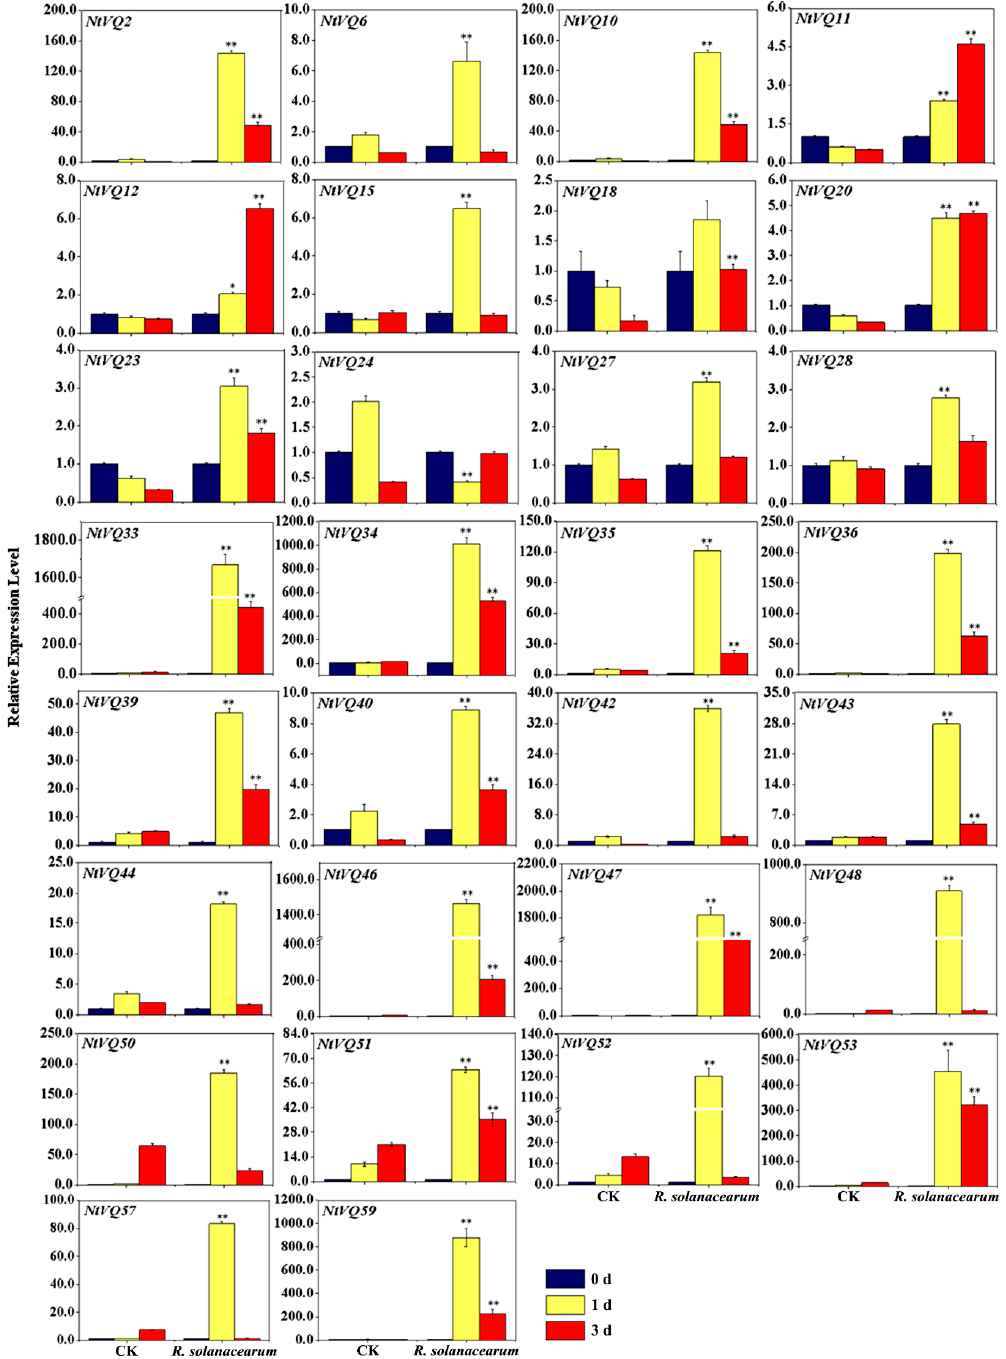
Figure 7. Expression analysis of significantly modulated NtVQ genes in response to challenge by Ralstonia solanacearum . Four-week-old seedlings were inoculated with 50 μ L bacteria (OD = 0.001) for 0, 1 and 3 d before the leaf tissues were harvested for RNA extraction. The relative expression value of each NtVQ gene was normalized to NtEF1 α with CK at 0 h as calibrator. CK, control group inoculated with 10 mM MgCl 2 . * indicates the level of significance relative to the CK value (* p < 0.05, ** p < 0.01).